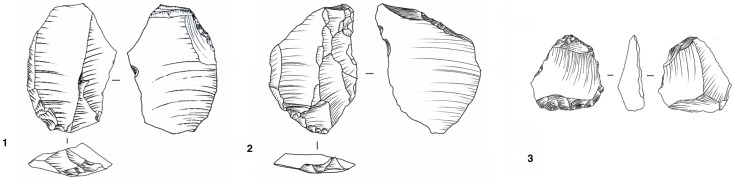
Bau de l’Aubesier.Truncated pieces from unit K (n. 1 and 2) and unit J4 (n.3).